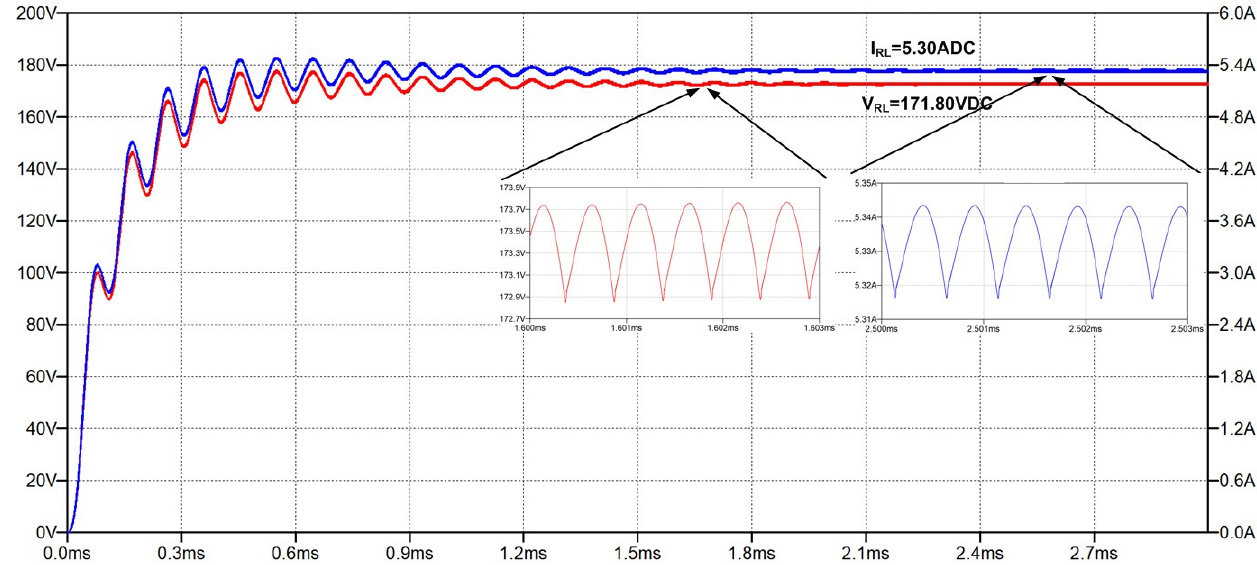
Figure 20. Input voltage (blue), output voltage (blue), input current (red), and output current (green), P o = 1 kW.